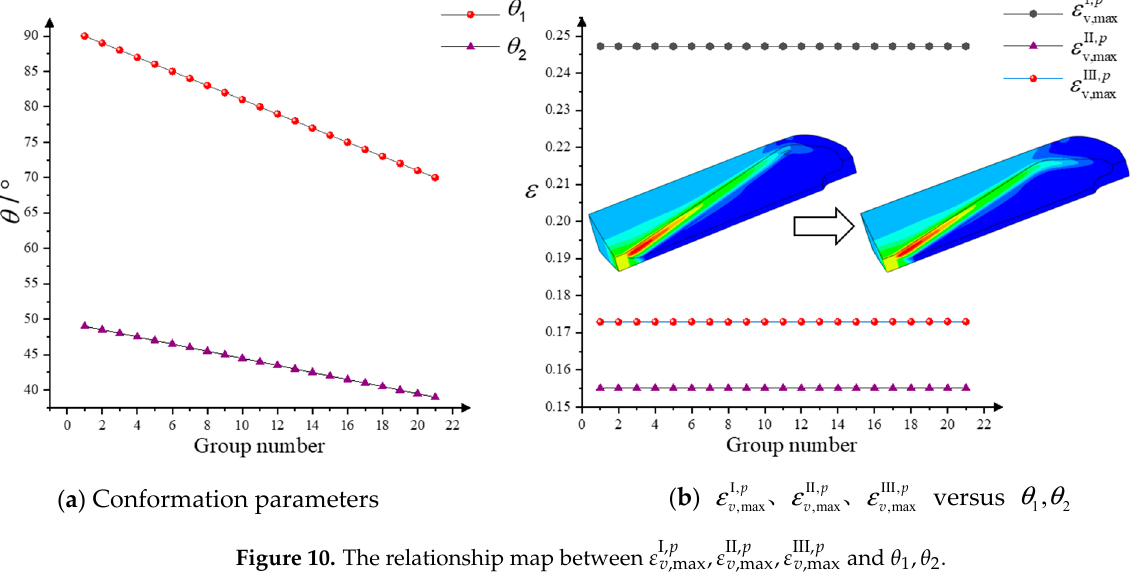
Figure 10. The relationship map between ε I, p v ,max , ε II, p v ,max , ε III, p v ,max and θ 1 , θ 2 .